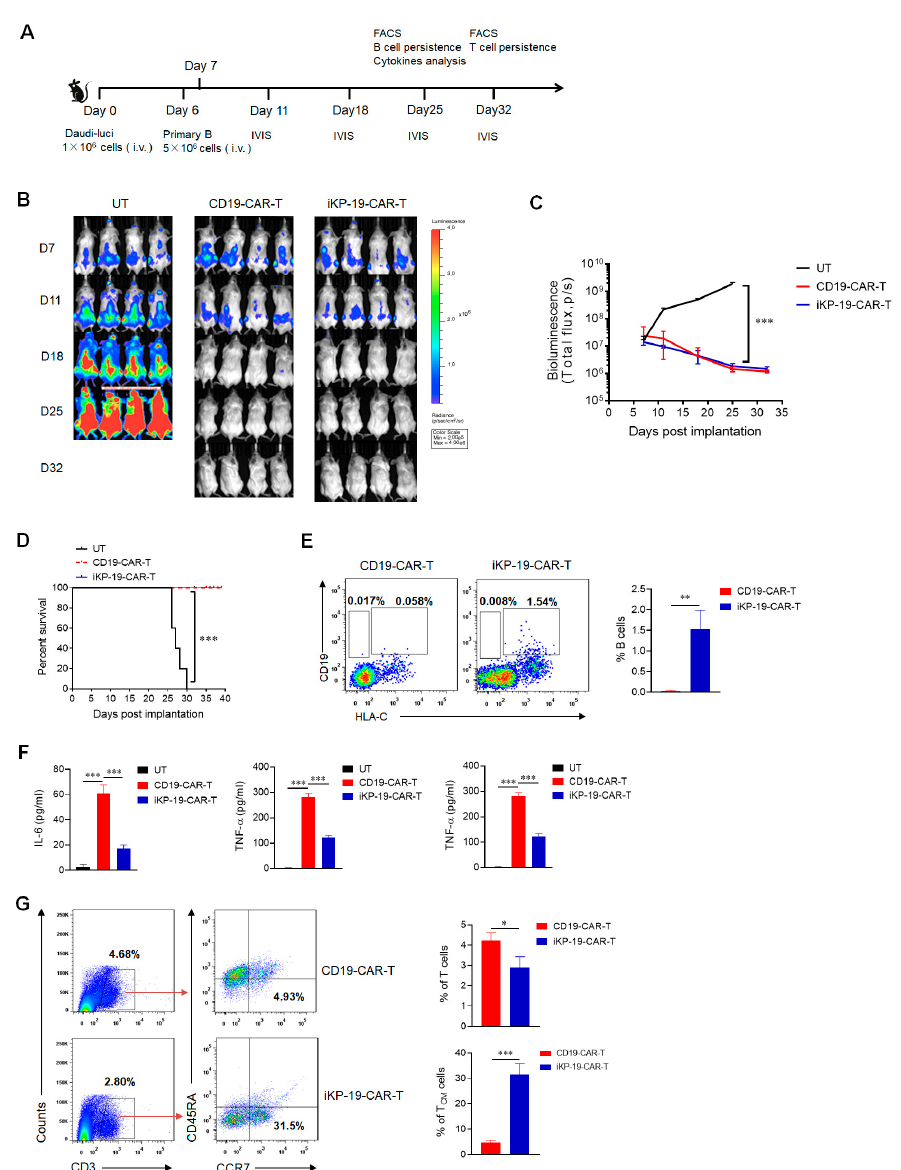
Figure 6. Controlling B cell malignancy effectively with sparing normal B cells in vivo of iKP-19-CAR-T cells. ( A ) Schematic representation of in-vivo experimental design. NCG mice (n = 4/group) were i.v. injected with 1 × 10 6 luciferase-expressed Daudi cells (Daudi-luc) on day 0. After 6 days, 5 × 10 6 normal B cells were administered. At day 7, 5 × 10 6 UT cells, CD19-CAR-T cells and iKP-19-CAR-T cells were i.v. injected. IVIS imaging was performed to monitor tumor burden at day 11, 18, 25, 32. At day 25, normal B cells and cytokines in PB were analyzed. At day 32, T cells persistence was evaluated. ( B ) Representative bioluminescence images of Daudi-luc cells-derived tumor growth in the xenograft model. ( C ) Bioluminescence kinetics of Daudi-luc cells-derived tumor growth in the xenograft model. ( D ) Kaplan-Meier survival curve of mice. ( E ) Representative presence of Daui cells (CD19 + HLA-C1 − ) or normal B cells (CD19 + HLA-C1 + ) in mice at day 25 was determined by flow cytometry using APC- anti-human CD19 antibody and PE-anti-human HLA-C antibody. ( F ) Cytokine secretion of IL-6, IFN- γ and TNF- α in PB at day25 was measured by using CBA assay kit. ( G ) Flow cytometer analysis of total numbers of T cells and central memory T cells (T CM ) in different group of xenograft mice. T cells